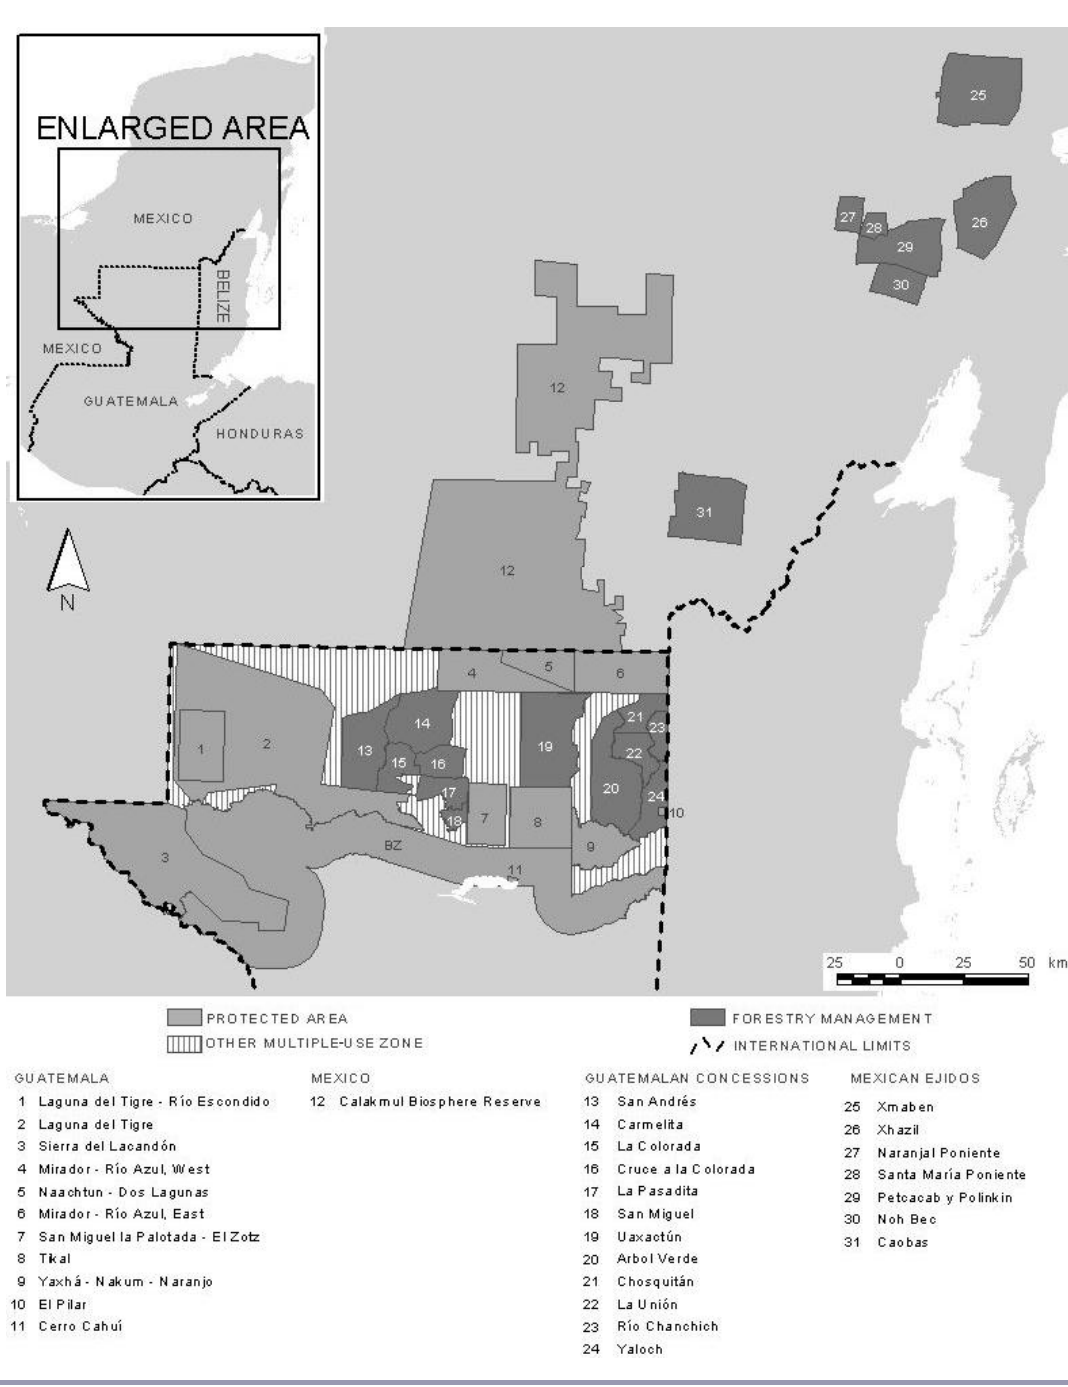
Fig. 1. The Maya Forest of Mexico and Guatemala, with the locations of the protected areas and community forests analyzed. Used with permission from Consejo Civil Mexicano para la Silvicultura